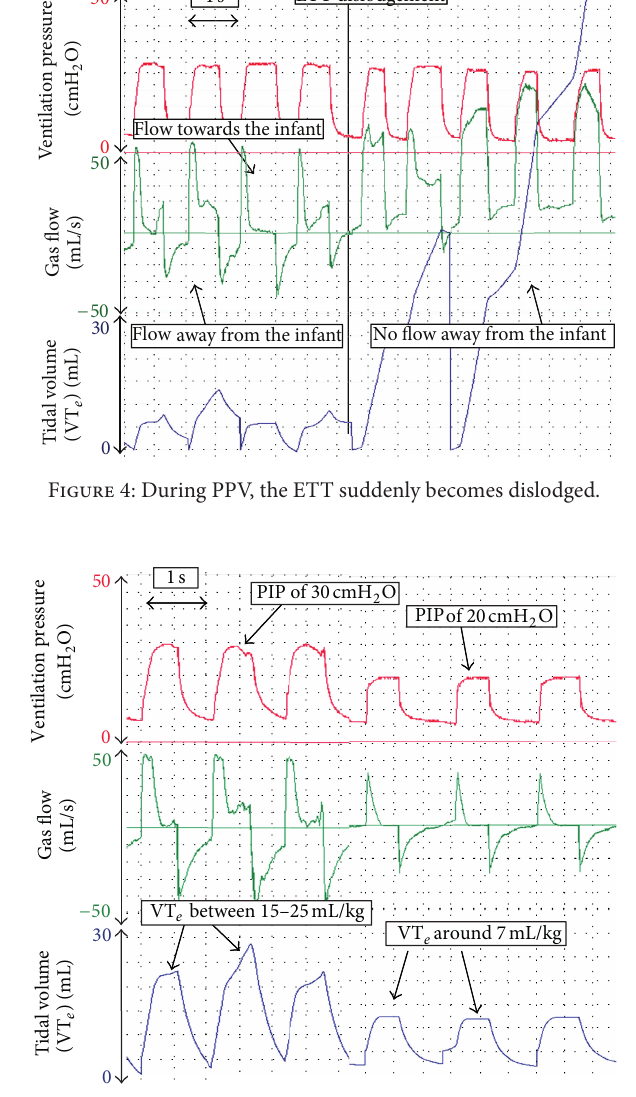
Figure 5: During PPV, the delivered 𝑉 𝑇 is between 21 and 30 mL/kg. Once the PIP is decreased from 30cm H 2 O to 20 cm H 2 O, the displayed 𝑉 𝑇 decreases to around